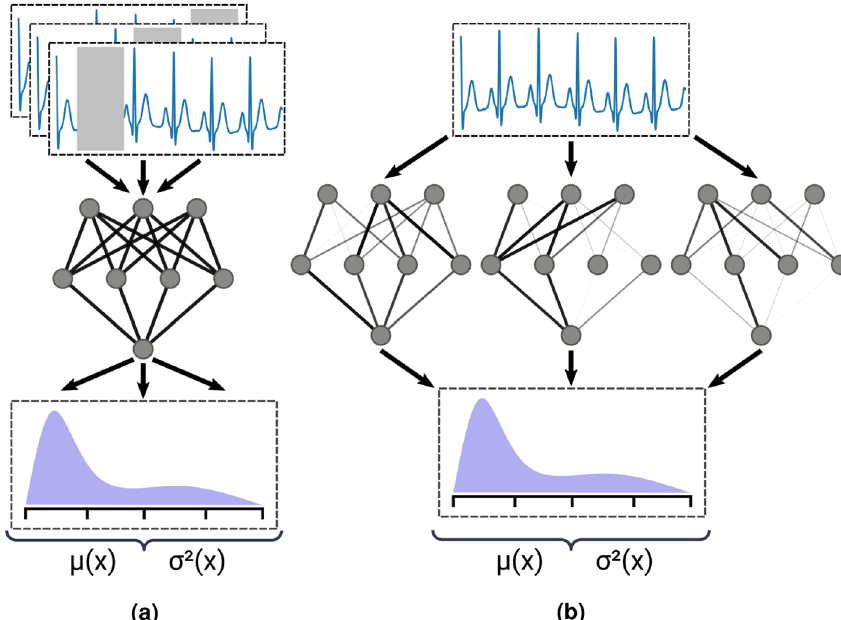
Figure 4. Visual comparison of aleatoric and epistemic uncertainty estimation techniques. ( a ) Test-time augmentation randomly samples multiple views of each input. ( b ) Monte Carlo dropout samples multiple configurations of the model weights by randomly excluding a subset of